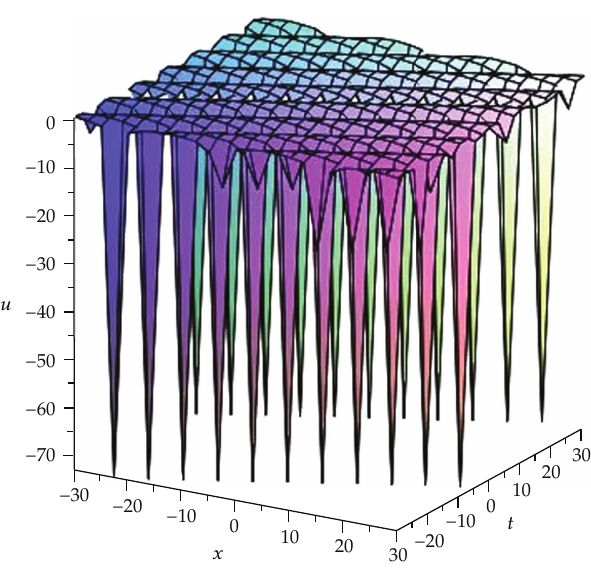
Figure 7: The solution u 7 of GSWW equation with k (cid:7) 0 . 3, c (cid:7) 2, α (cid:7) 3, β (cid:7) 1.